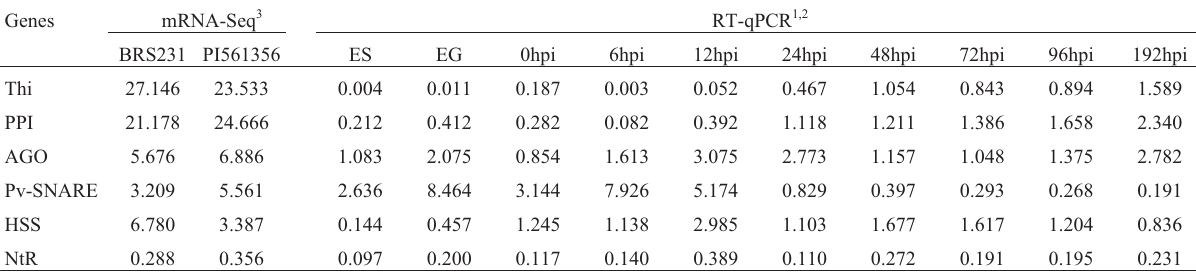
Table 5 - Validation of gene expression base on mRNA-Seq assay using